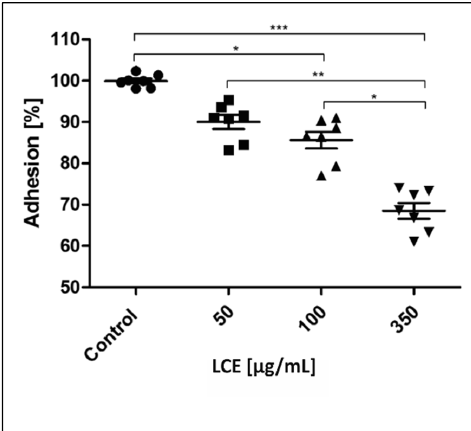
Figure 7. Effect of L. cardiaca L. extract (LCE) on human blood platelet adhesion to fibrinogen. The results are presented as a percentage of control for single individuals and expressed also as a median % ±